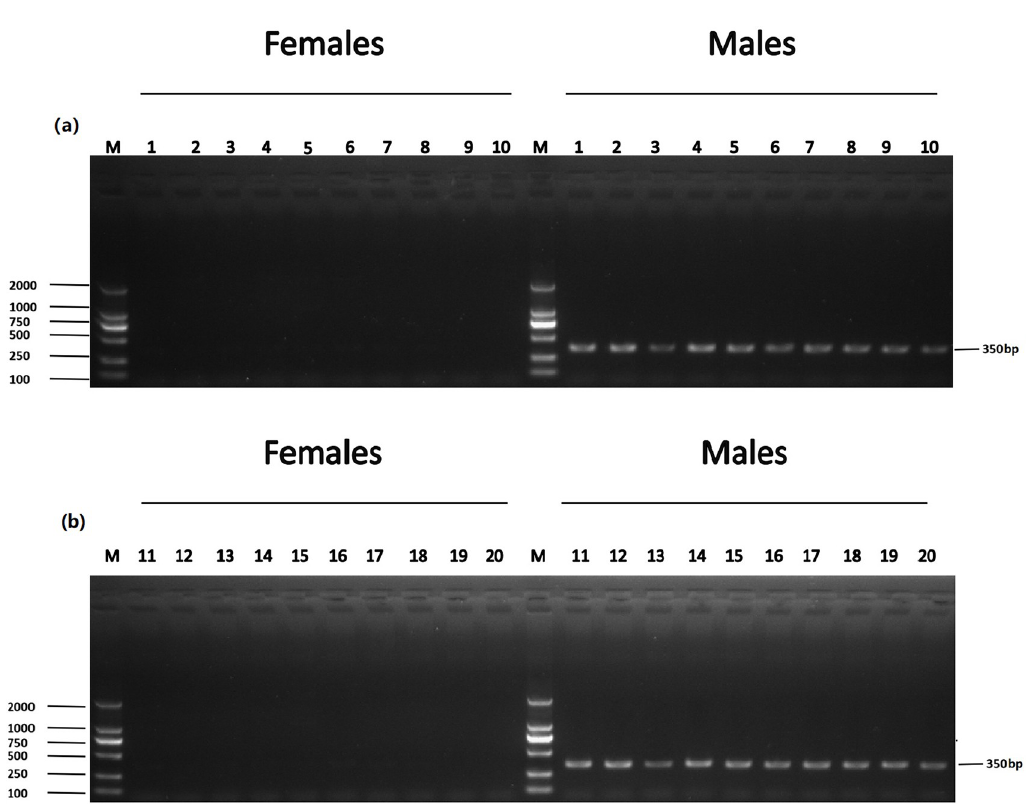
Fig 3. Identification of a male-specific tag, DNA fragment, amplified with Tag8736997. The left shows DL 2000 DNA marker sizes; the right shows fragment sizes.